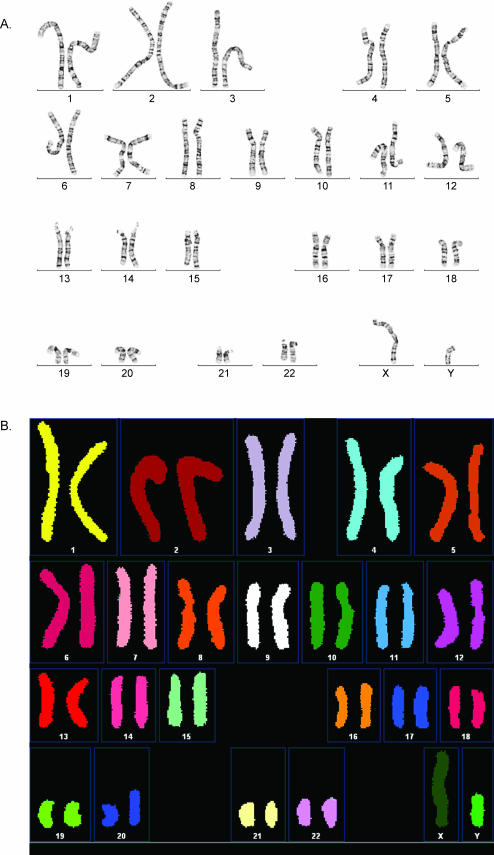
Results of Cytogenetic Analysis(A) HuRef donor G-banded karyotype. (B) Spectral karyotype analysis.